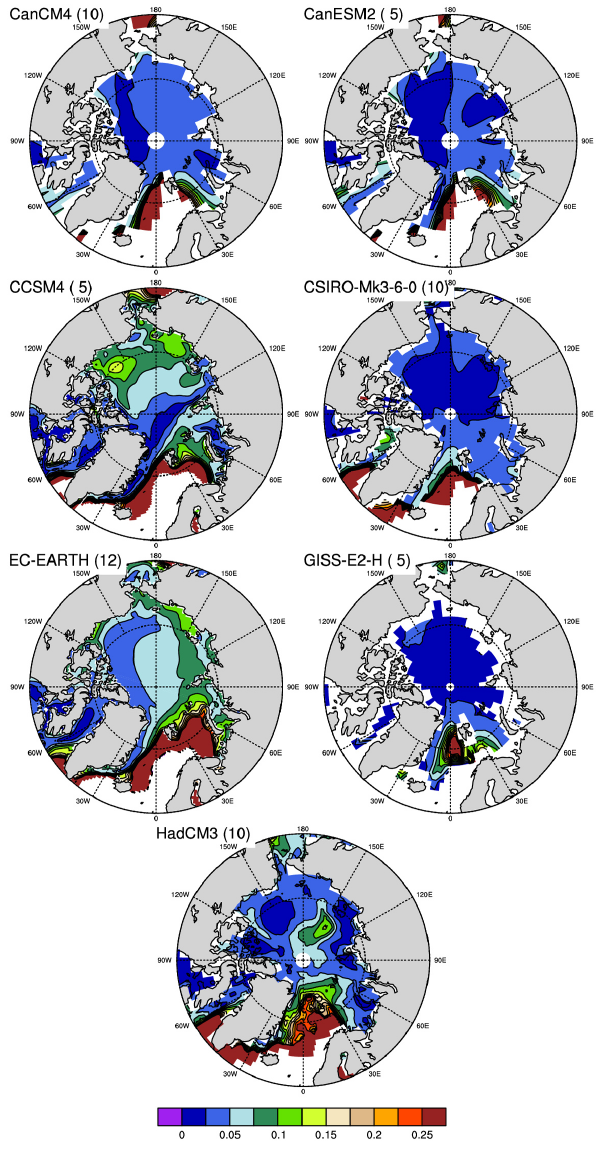
Figure 1. Variability of March ice thickness in seven models from 1981 to 2010. The values are the coefficient of variability (SD/average). This is a normalized measure of variability so that variability can be compared spatially and between